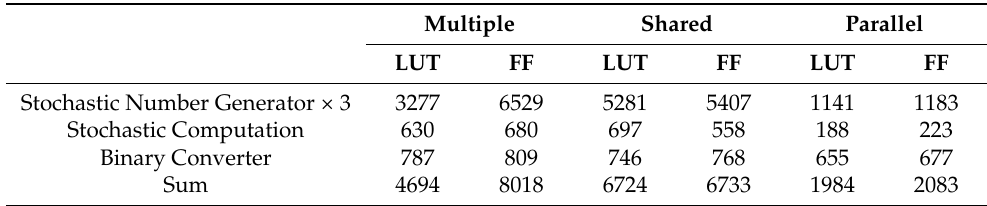
Table 1. Hardware efficiency evaluation.